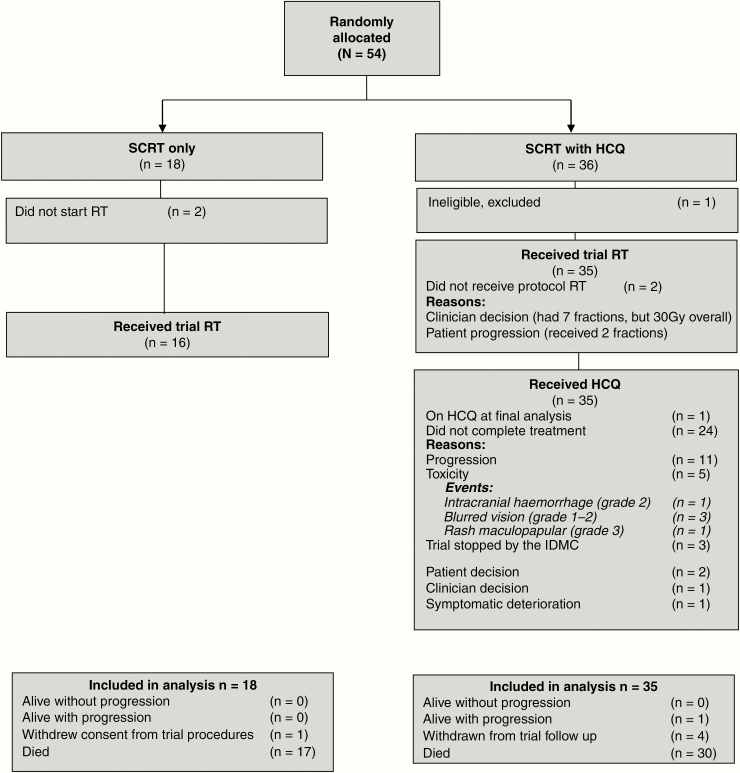
Consort diagram.